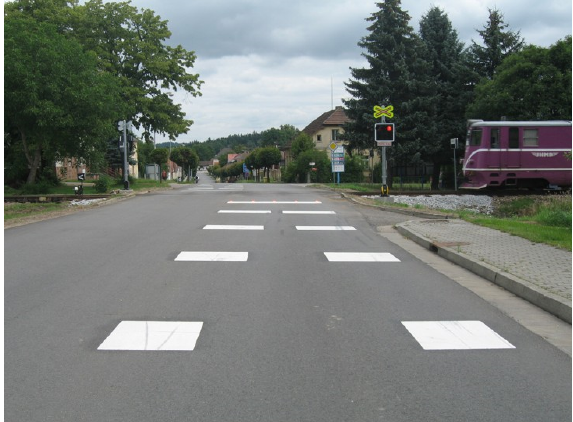
Figure 3. Level Crossing Highlighted by ’light bar’ and Optical Psychological Brake (source Mr Skladany).